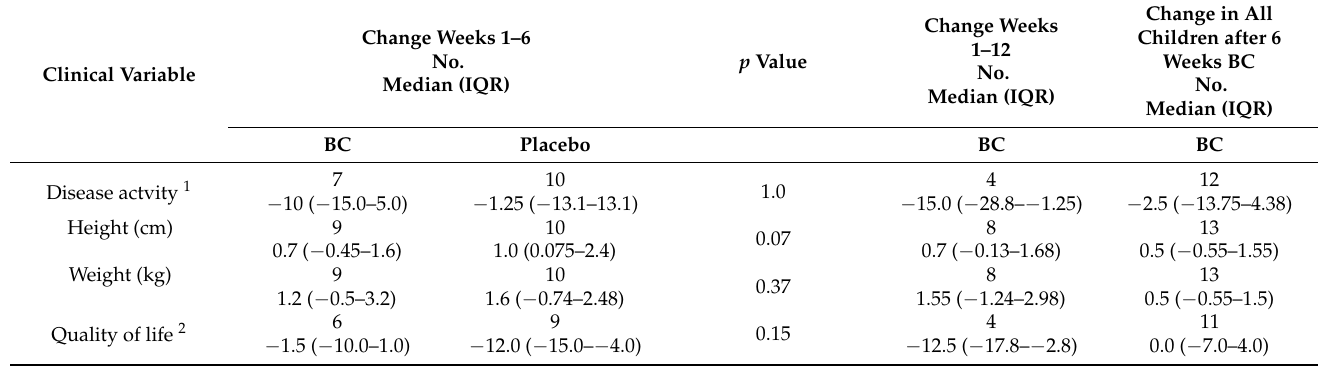
Table 2. Clinical variables at recruitment and change according to intervention